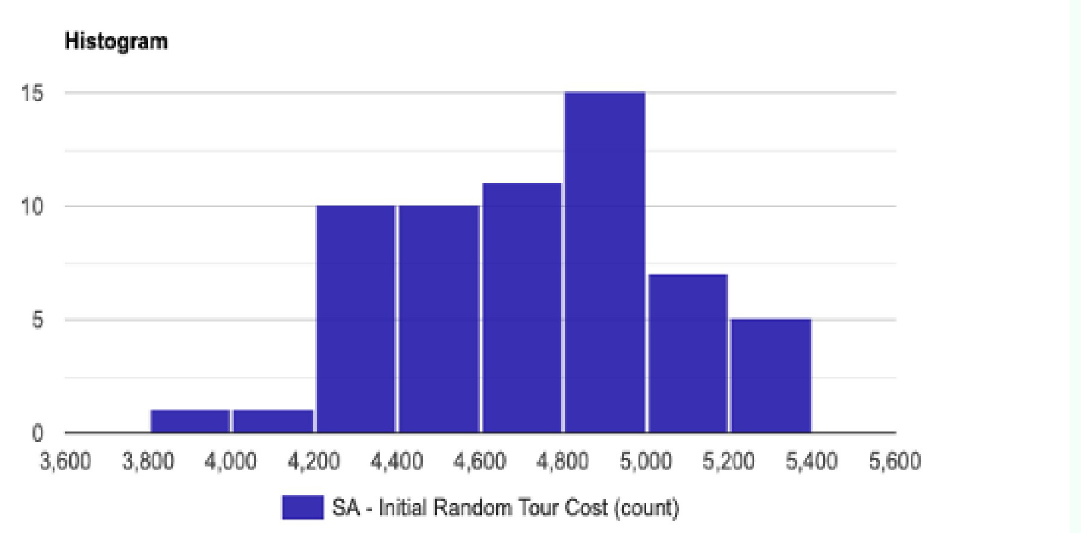
Fig 34. Histogram for the initial tour cost in the SA